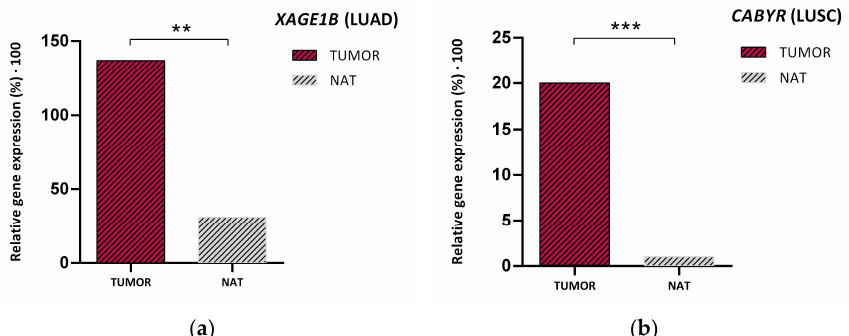
Figure 9. Median relative expression of ( a ) XAGE1B and ( b ) CABYR in tumor tissue from the HGUV NSCLC resected cohort vs. its expression in NAT (normal adjacent tissue). p -values were obtained with ** p ≤ 0.01, and *** p ≤ 0.001.